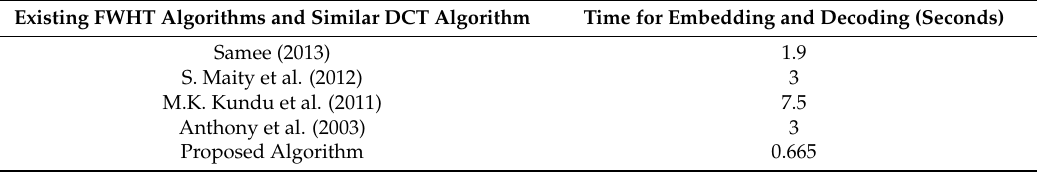
Table 1. Execution Time for Different